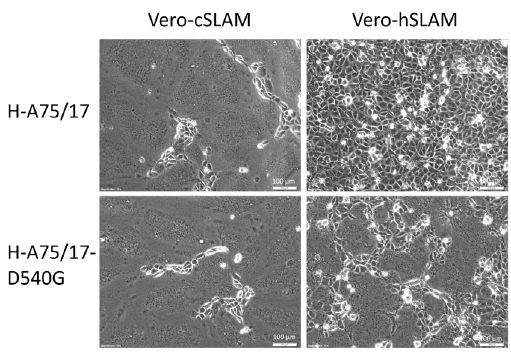
Figure 6. Syncytium formation after co-transfection of plas- mids expressing CDV-H and -F proteins. Vero-cSLAM and Vero- hSLAM cells were transfected with plasmids expressing wild-type CDV- H A75/17 and mutated H A75/17-D540G in combination with wild-type CDV-F as indicated, and incubated for 24 h before phase-contrast micropho- tographs were taken (bar=100 m